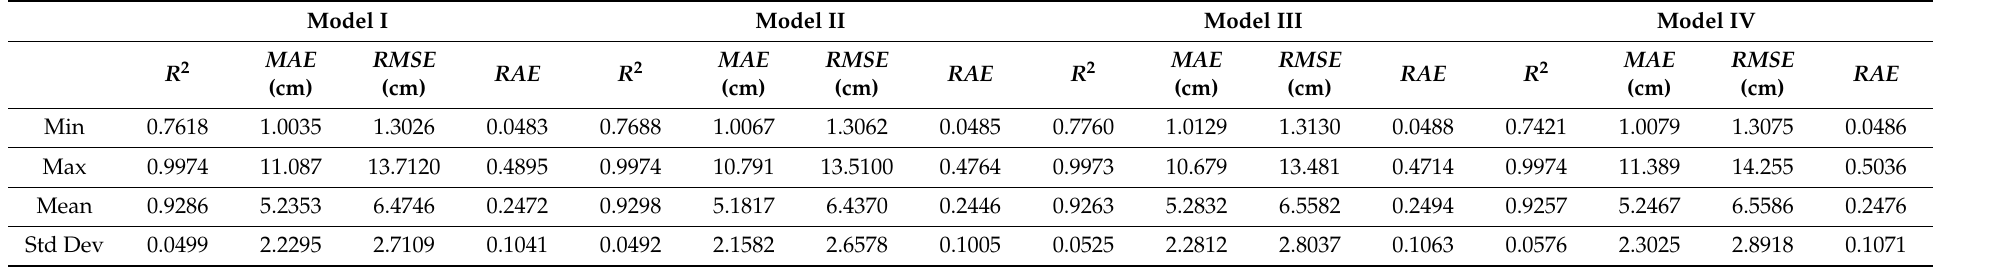
Table 4. Venice Lagoon prediction